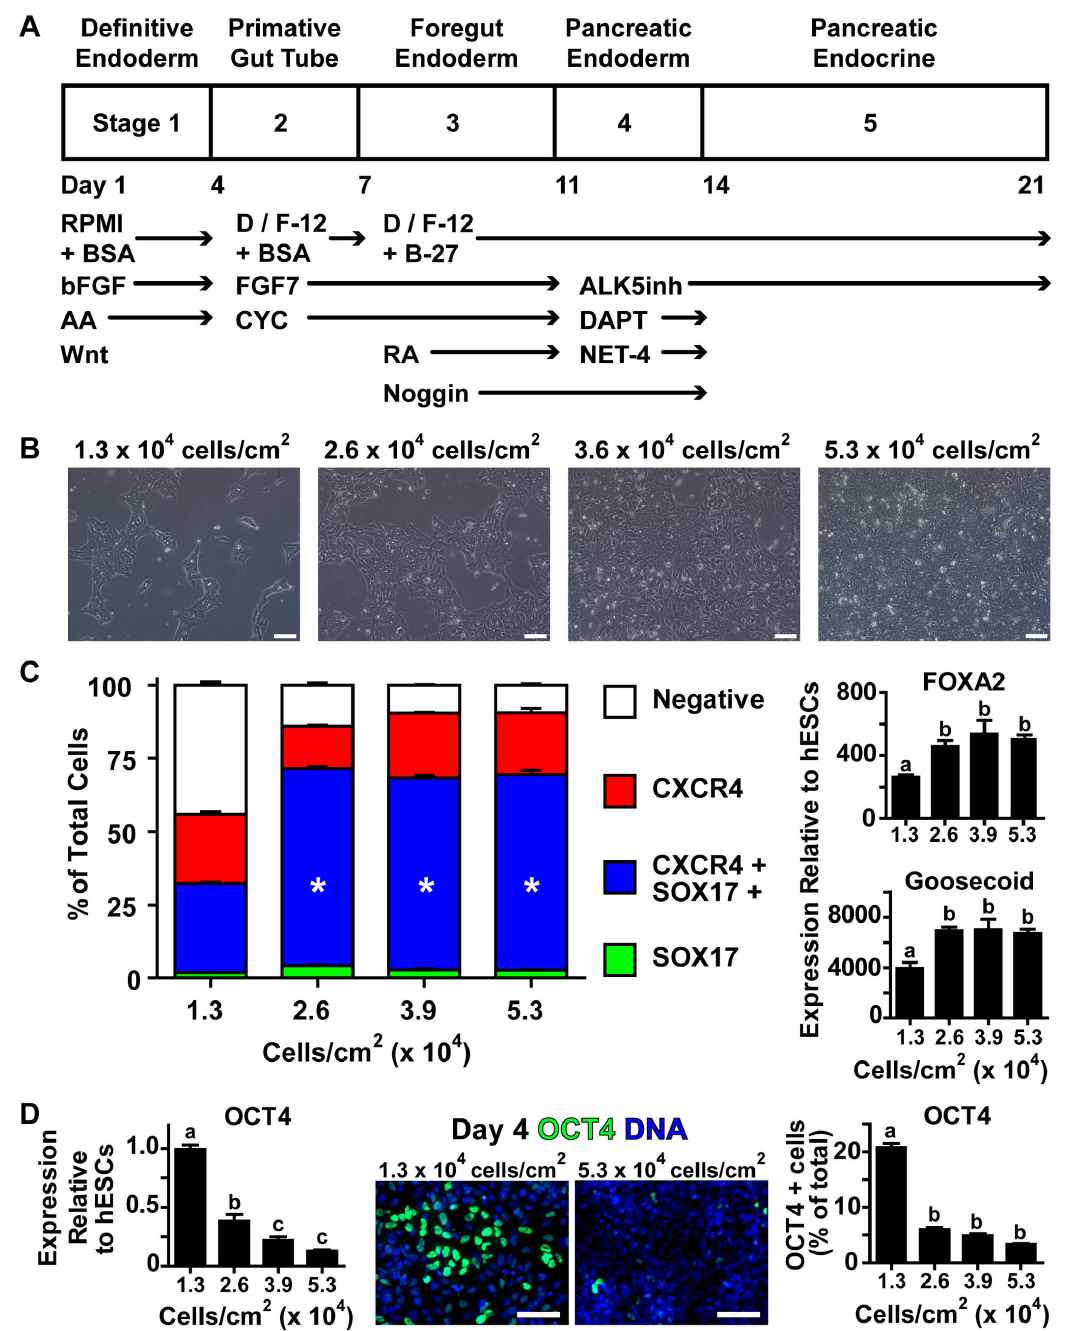
Figure 1. Higher Cell Seeding Density Improves Definitive Endoderm Differentiation. (A) CA1S hESCs were differentiated using a protocol designed to mimic human development in a 21 day, 5 stage process. (B) hESCs were seeded onto matrigel-coated culture plates at the indicated density, yielding 30%-100% confluence as shown at 24 hours after seeding. (C) On day 4 of differentiation, markers of definitive endoderm induction were assessed by flow cytometry (CXCR4 and SOX17 expression) or RT- qPCR ( FOXA2 and Goosecoid, shown relative to undifferentiated hESC expression levels). (D) Expression of OCT4 (marker of pluripotent cells) was assessed by RT-qPCR and immunofluorescence as a percentage of the total number of nuclei (OCT4 is green, nuclei are blue). * represents significant difference from 1.3 x 10 4 cells/cm 2 by one-way ANOVA with Bonferroni post-hoc test. Different superscripts (a, b, c) are significantly different from each other within each graph by one-way ANOVA with Bonferroni post- hoc test. Scale bars are 100 μm. doi: 10.1371/journal.pone.0082076.g001 PLOS ONE |